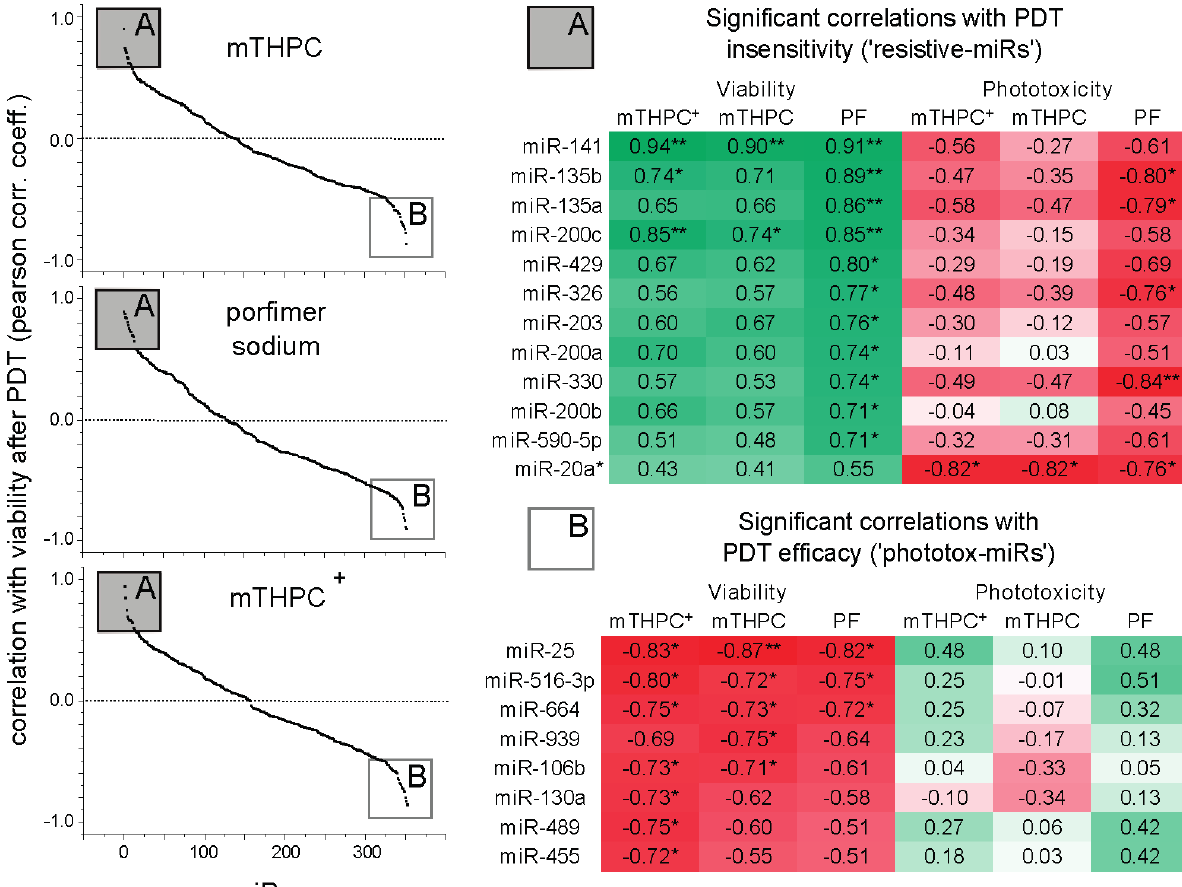
insensitivity (A, positive correlation with viability after PDT) or phototoxicity (B, negative correlation with viability after PDT). The color indicates positive (green) and negative (red) correlation coefficients. Correlations with viability and (uptake-corrected) phototoxicity show reciprocal trends. Of note, miR-20a* correlates significantly only with the three data sets for uptake-corrected phototoxicity. + Based on phototoxicity raw data as previously published [13], reproduced by permission of The Royal Society of Chemistry (RSC) on behalf of the European Society for Photobiology, the European Photochemistry Association, and RSC; the full list of correlations is provided in supplementary file 2. * p < 0.05; ** p < 0.01; abbreviations: PF: porfimer